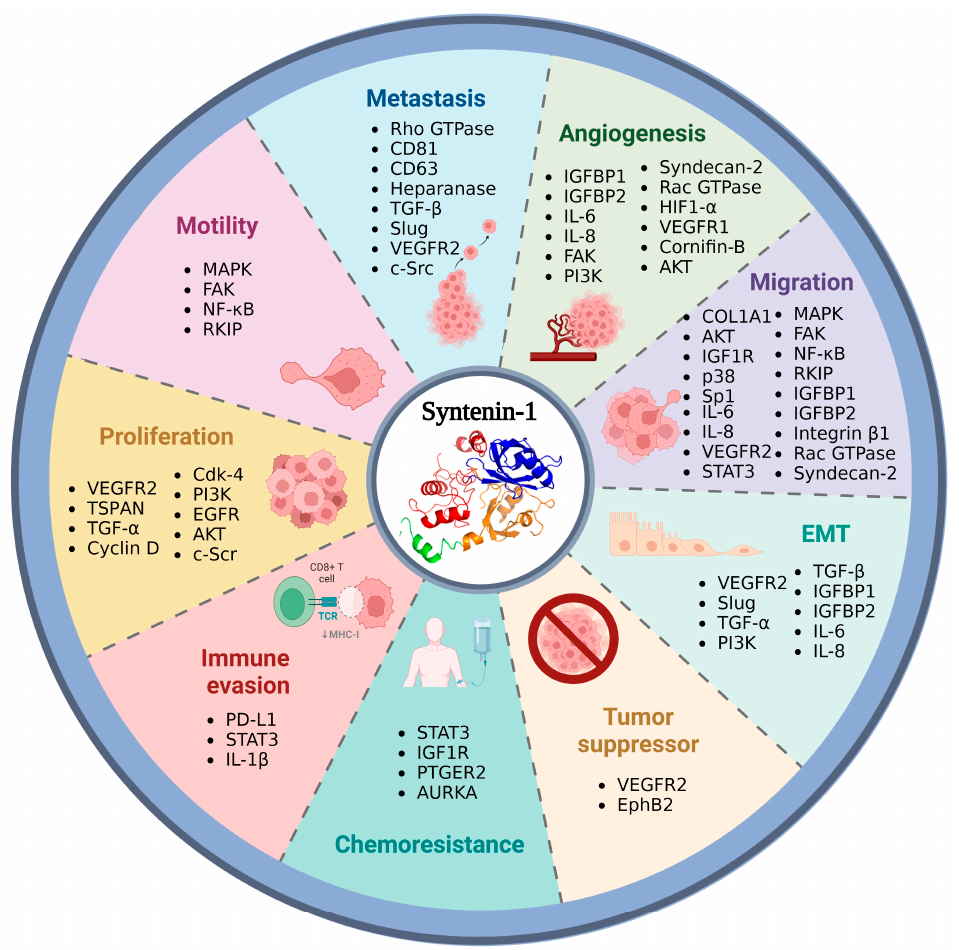
Figure 3. Overexpression of syntenin-1 and cancer development. The overexpression of syntenin-1 is related to angiogenesis (IGFBP1, IGFBP2, Rac GTPase, PI3K, Syndecan-2, HIF1- α , and SPRR1B), metastasis (TGF-beta, Rho GTPase, Slug, c-Src, Heparanase), migration (COL-1, AKT, MAPK, p38, SP1, and Syndecan-2), EMT (TGF-beta, VEGFR, IL6, and IL8), chemoresistance (STAT3, IGF-1R, PTGER2, and AURKA), proliferation (Cdk-4, TSPAN, Cyclin D, TGF-alfa, and s-Src), and motility (MAPK, FAK, NF-kB, and RKIP), also shows a tumor suppressor role by its interaction with VEGFR2 and EphB2. Image created in BioRender (www.biorender.com, accessed on 14 February 2023).